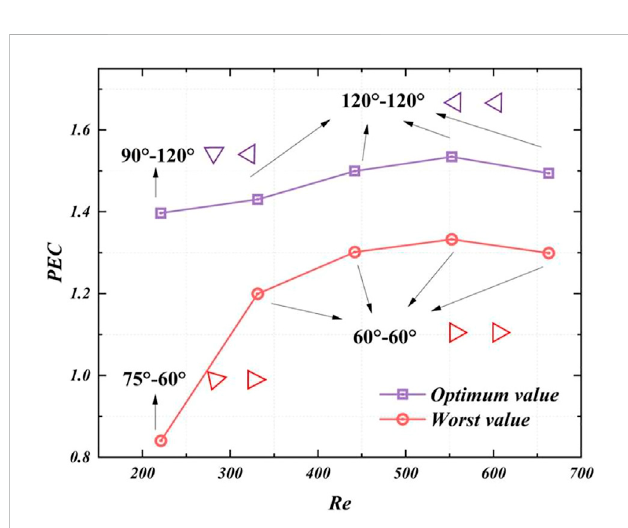
FIGURE 16 The optimum and worst minichannel con fi gurations on different